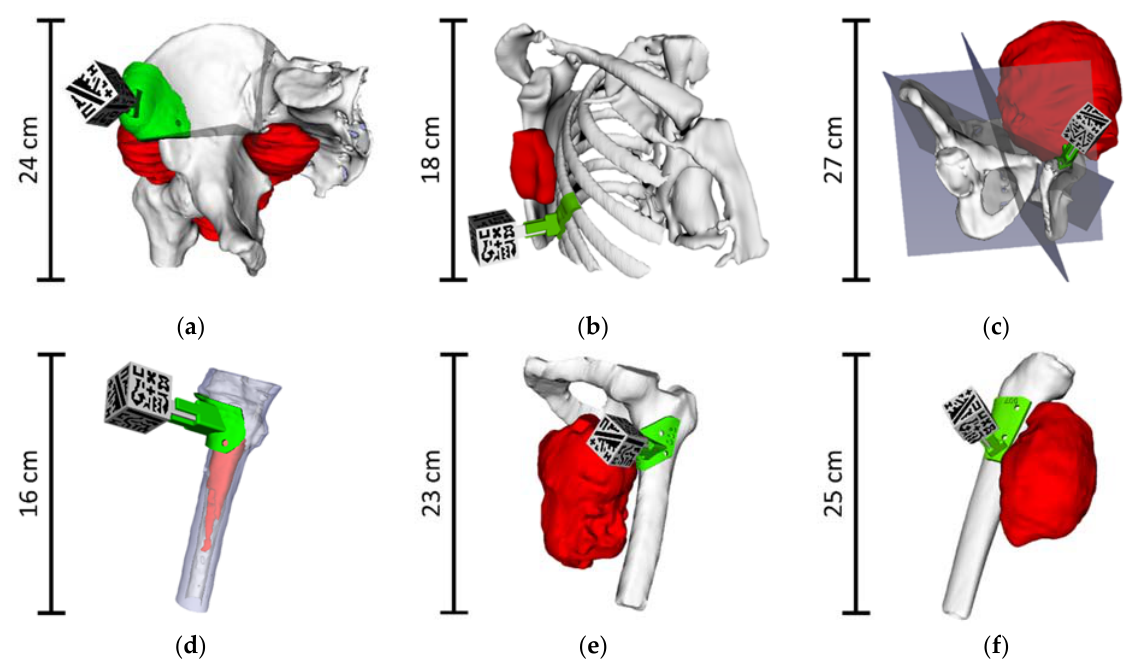
Figure 2. Virtual 3D models from patients: ( a ) AR3DP0002; ( b ) AR3DP0003; ( c ) AR3DP0004; ( d ) AR3DP0005, with some transparency in the bone to display the inner tumor; ( e ) AR3DP0006; ( f ) AR3DP0007. Tumors are represented in red, bones in white and surgical guides in green. Surgical cutting planes are illustrated in semi-transparent gray in the cases that required them: ( a ) and ( c ). The 3D-printed marker reference is positioned in the surgical guide.